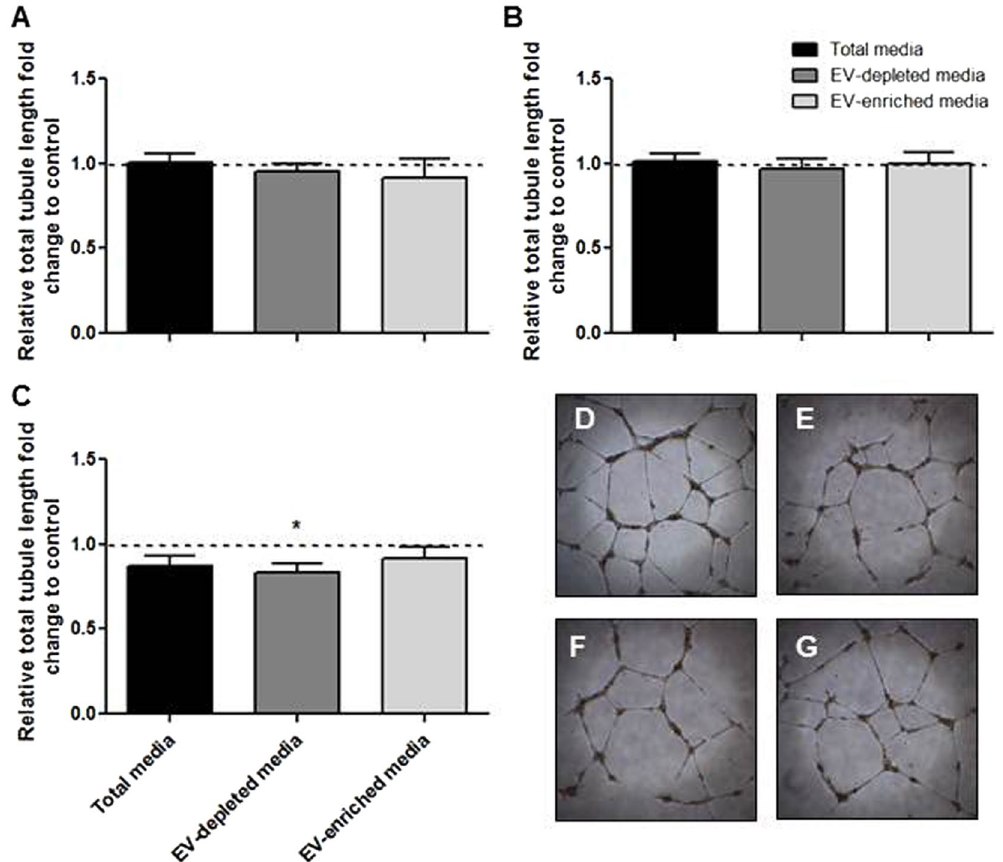
Figure 5. Angiogenic activity of HUVECs treated with ( A ) preterm or ( B ) term conditioned and enriched media was not altered. ( C ) HUVEC angiogenesis was moderately decreased when treated with PE conditioned media but not EV-enriched media. Representative images of ( D ) positive control, ( E ) total PE media, ( F ) EV- depleted media and ( G ) PE-EV enriched